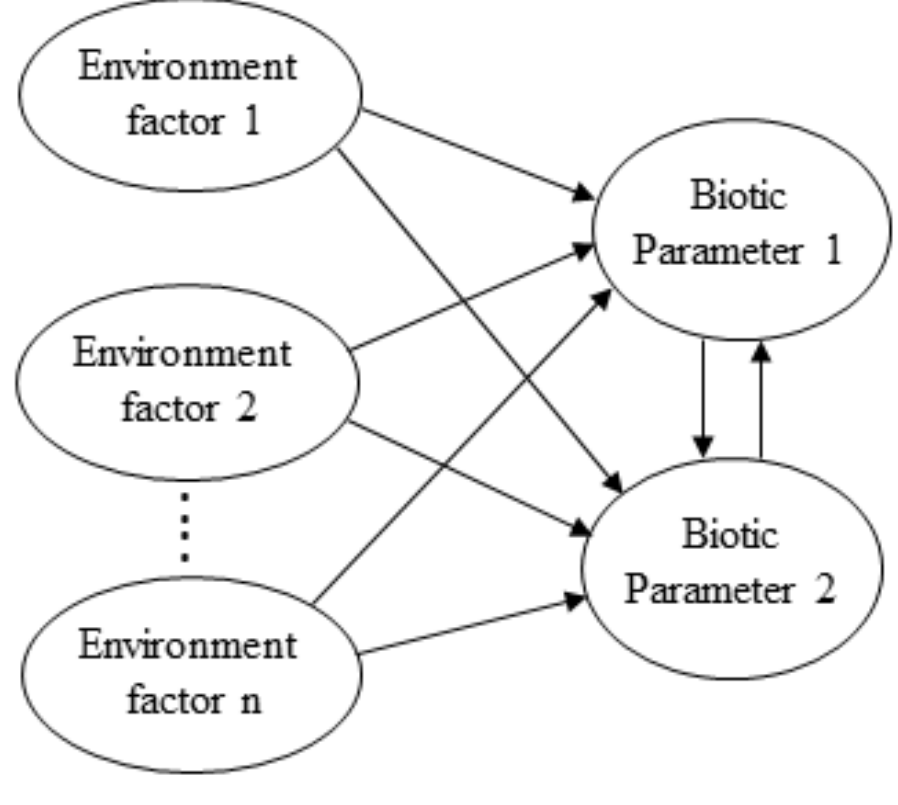
Figure 2. The hypothesized structural